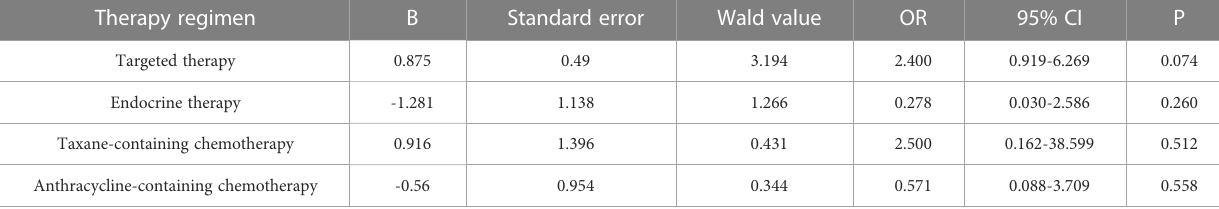
TABLE 7 Logistic multivariate analysis results of treatment regimens on changes in Ki-67 expression. Therapy regimen